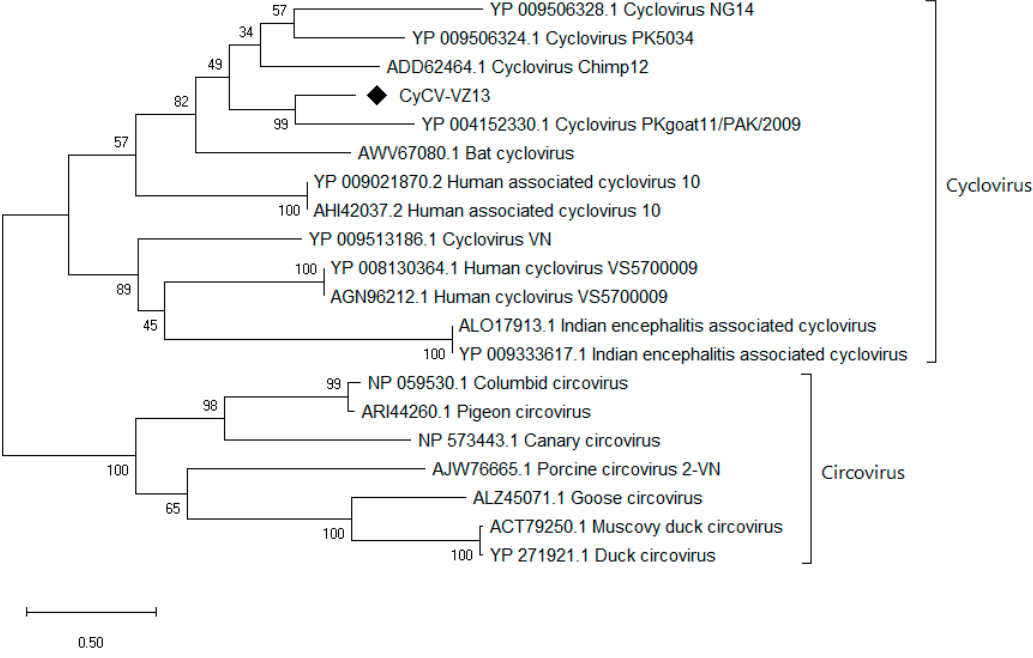
Cont . Figure 2. Figure 2.